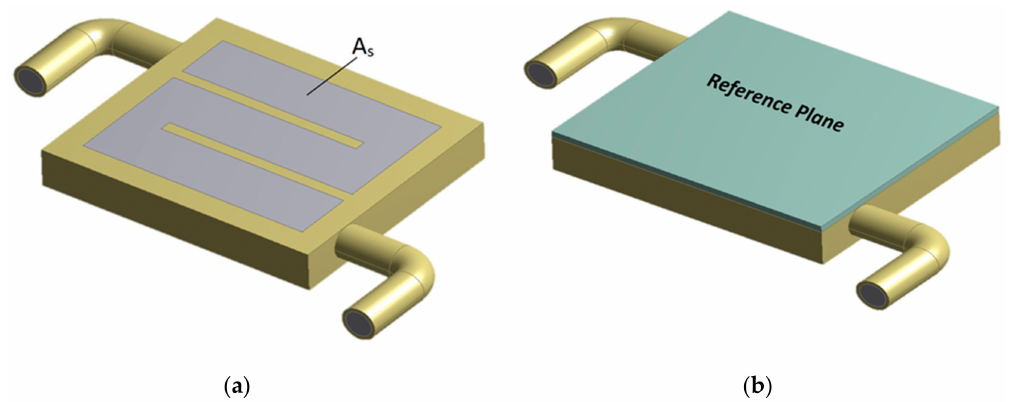
Figure 6. ( a ) The total heat transfer surface area ( A s ); ( b ) The reference